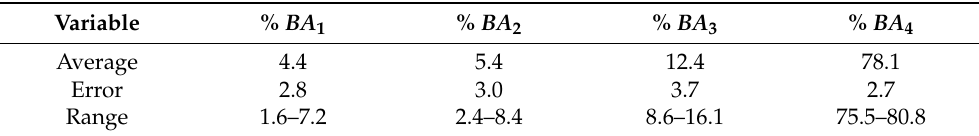
Table 1. Percentage ranges of basal area (% BA i ) for the strictly uneven-aged stand (average and error data from plots in Uholka, Valle Cervara, Serrahn and Kyjov).